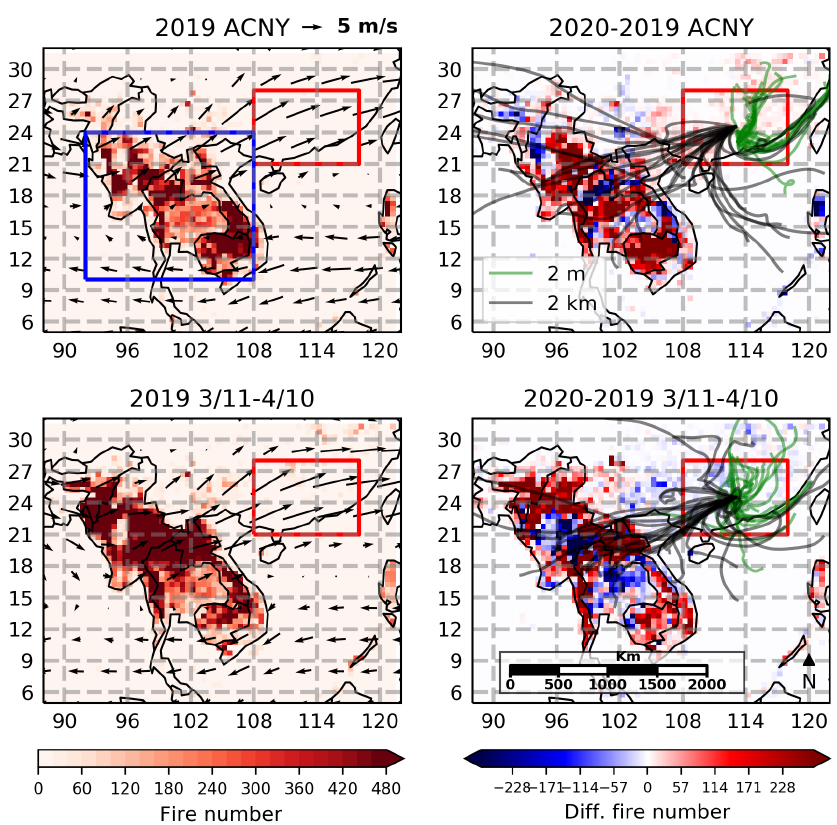
Figure 7. The number of fires observed by the Visible Infrared Imaging Radiometer Suite (VIIRS) satellite in 0.5 ◦ × 0.5 ◦ (latitude by longitude) grids over Southeast Asia (blue box) together with the wind at the 750 hPa from the ERA5 reanalysis data during ACNY and 3/11–4/10 in 2019 ( left ) and the difference in the number of fires between 2020 and 2019 ( right ). The green and black lines in the right panels are 3-day backward trajectories at 12:00 (local time) from 2 m and 2 km heights at the center of Region B (red box) for each day during ACNY and 3/11–4/10 2020 simulated by the Hybrid Single-Particle Lagrangian Integrated Trajectory (HYSPLIT)